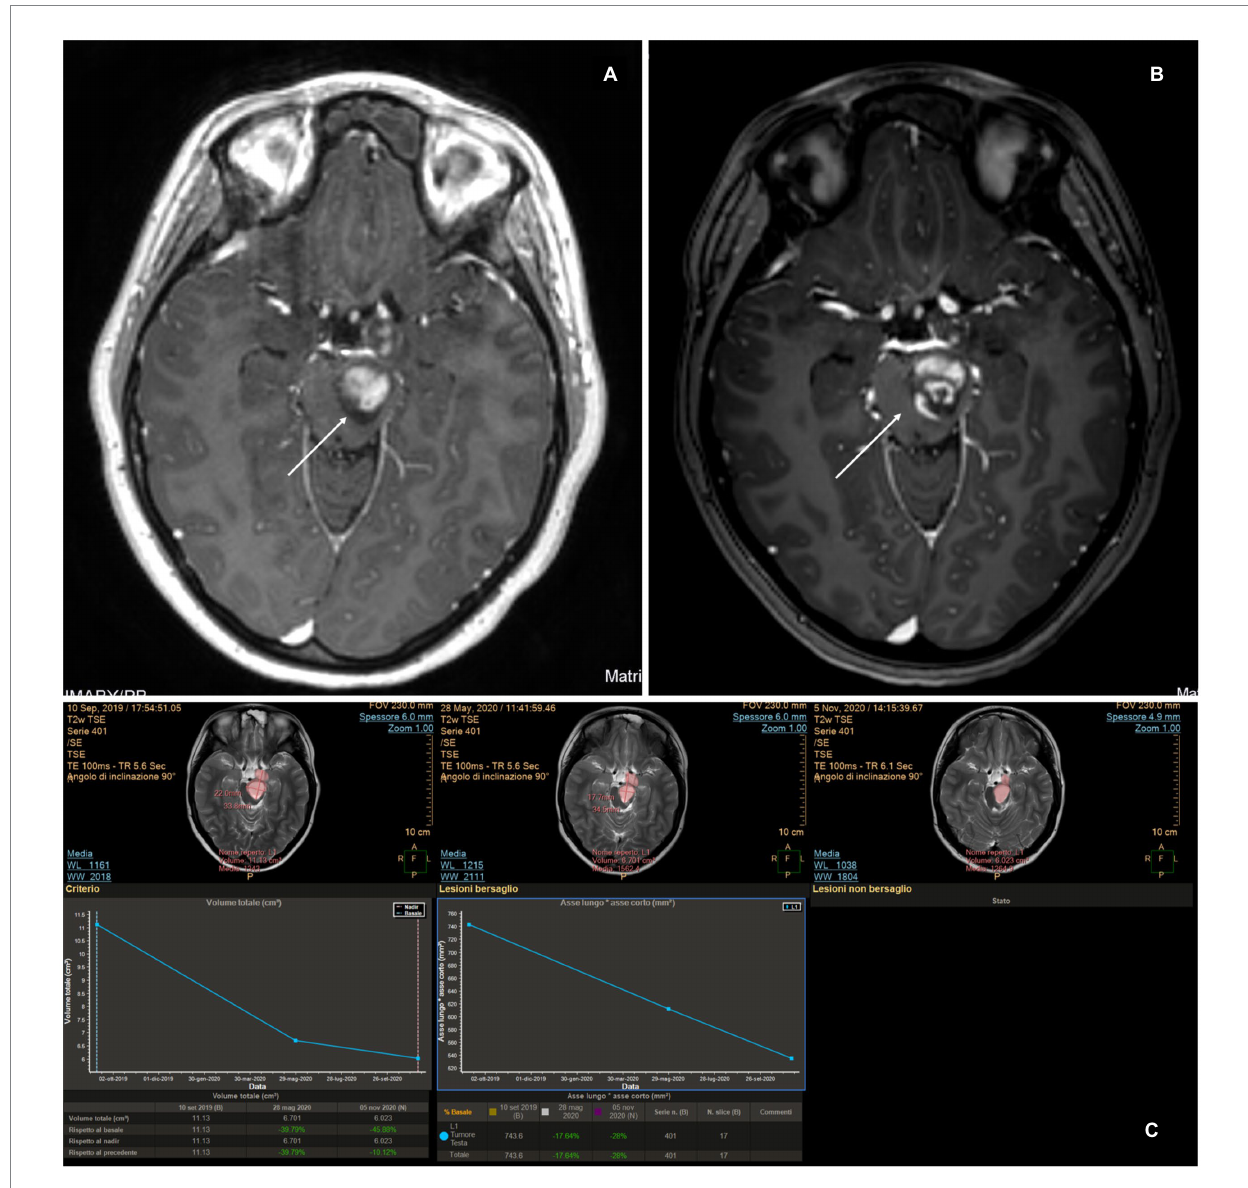
FIGURE 2 (A) Pre-operative magnetic resonance imaging (MRI). (B) MRI at 48 h after magnetic resonance-guided laser interstitial thermal therapy. A change in the post-contrast enhancement is made evident, compared to the pre-operative scan in panel (A) . A lack of enhancement in the central portion of the tumor where the thermal effect induced coagulation and necrosis can be observed. (C) MRI examined with the MITT Intellispace Portal. At 12 months after surgery, the tumor was found to have reduced by 46% in volume compared to pre-operative imaging and by 11% compared to the scan 6 months after